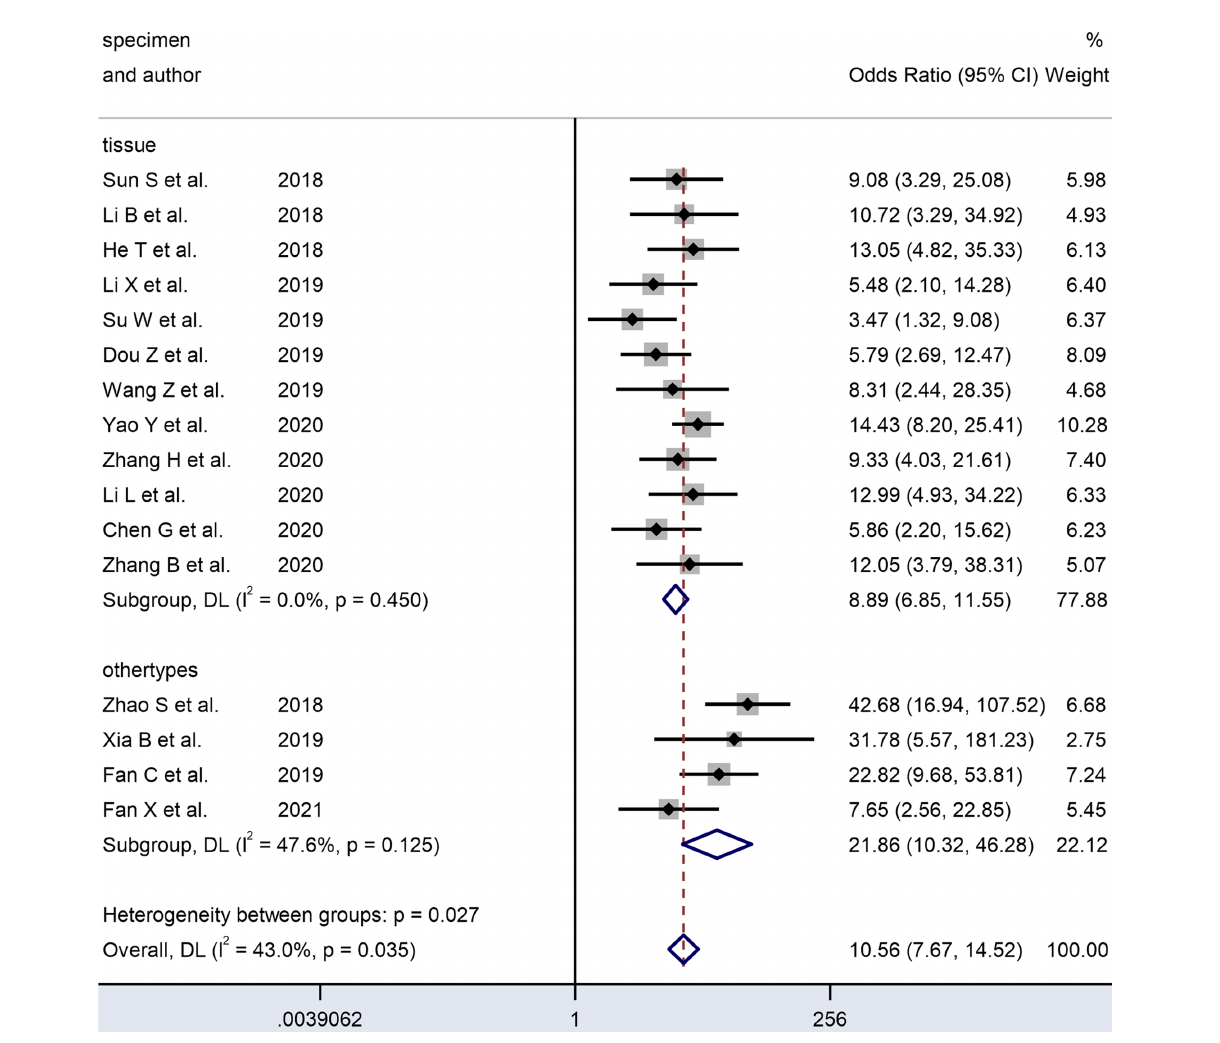
FIGURE 7 | Forest plots of subgroup analysis of the combined ORs with 95%CIs according to specimen type of circRNAs in patients with